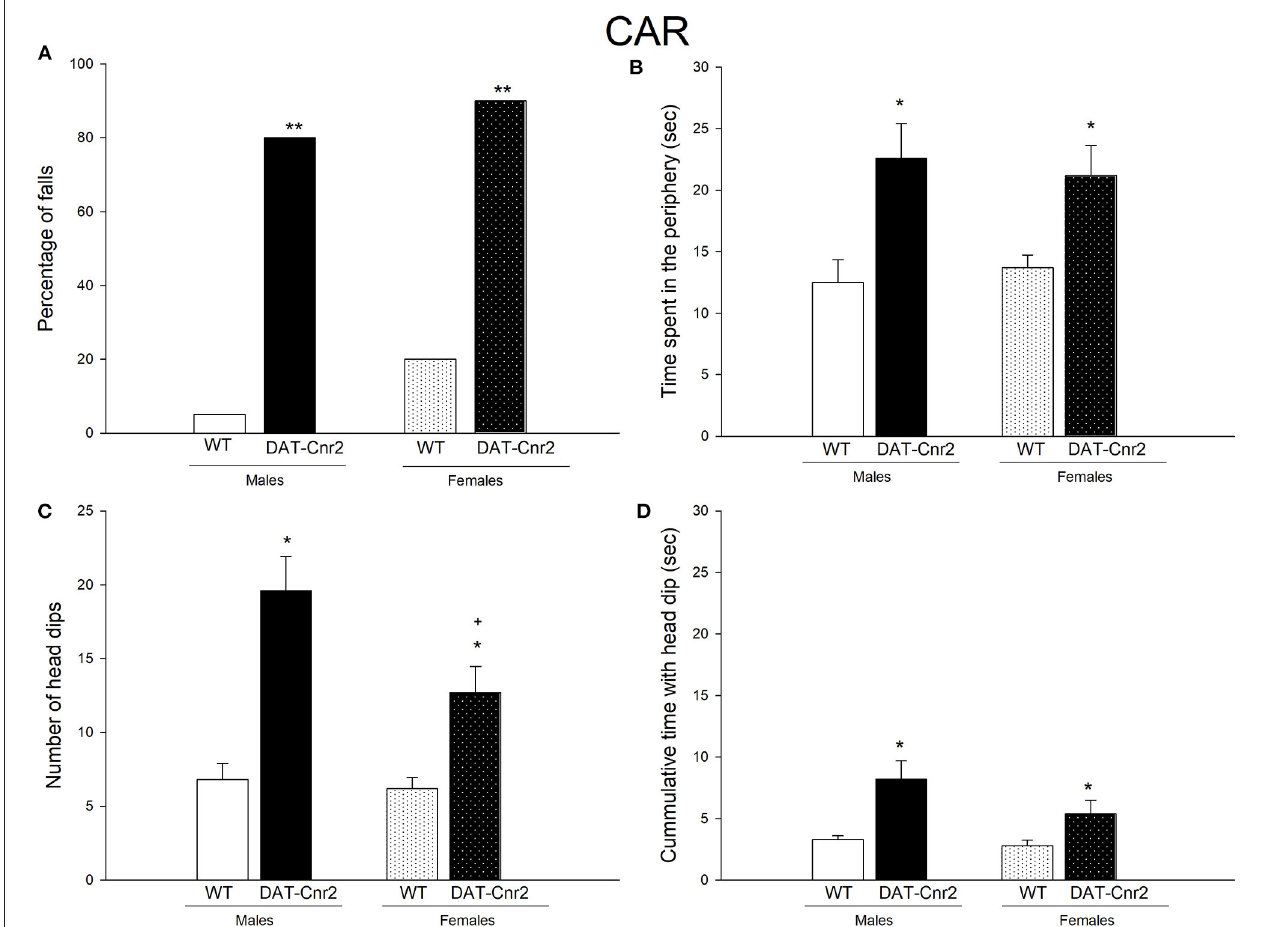
FIGURE 3 | Performance in the Cliff avoidance reaction (CAR) test. (A) depicts the percentage of animals falling from the platform. (B) Time spent exploring the periphery of the elevated platform. (C,D) show the number of head dips and the accumulative time with the head dip. White and White with dots represent the WT mice and the Black and Black with dots represent DAT-Cnr2 mice. The clear bars are the males and the bars with dots represent the females. Data are expressed as mean ± SEM (n = 10 mice per group). ** P < 0.01, Fisher F test for (A) . Two-way ANOVA followed by Tukey * p < 0.05 for genotypes; + p < 0.05 for